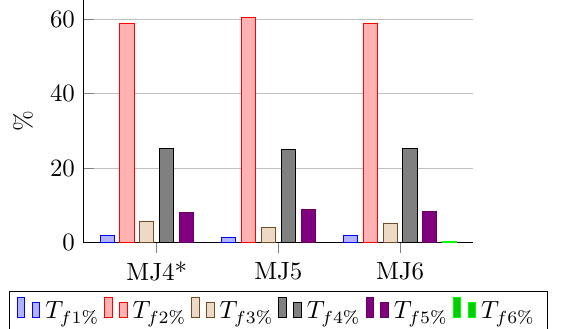
Figure 6: Each term from the friction models in per- centage of the accumulated friction force at 200bar, 250 cm 3 /rev and angular velocity from 300 to 2500rev/min. *For MJ4, C n in T f 2 equal 2.